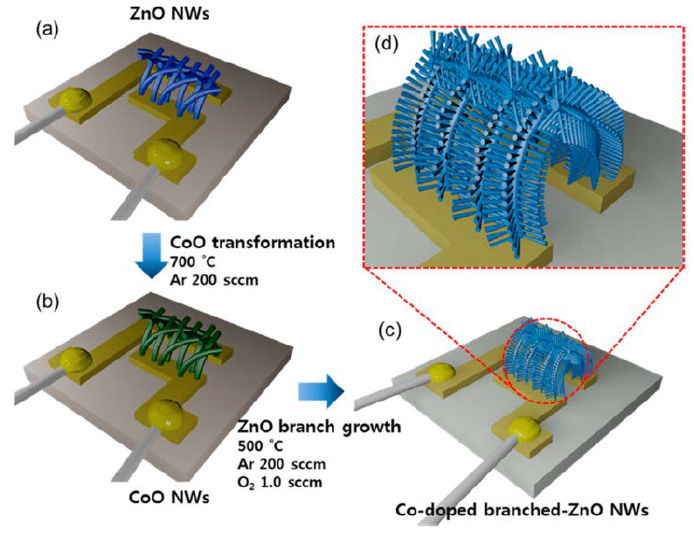
Figure 16. ( a ) ZnO nanowires, ( b ) transforming ZnO nanowires into CoO nanowires, ( c , d ) co-doped ZnO nanowire branches, “Reprinted/adapted with permission from Ref. [142]. 2014, Woo, H.-S. et al.”.